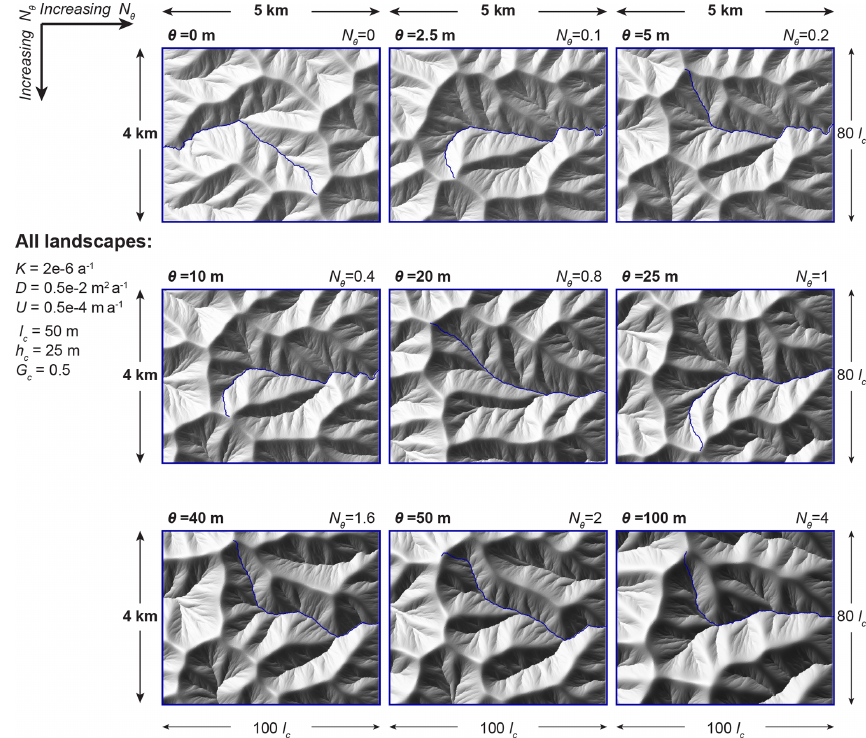
Figure 5. Influence of incision-threshold number N θ on morphology of ridges, hillslopes, and valleys. Shaded relief plots corresponding to the blue rectangular regions in Fig. 4 are arranged such that N θ increases from left to right and from top to bottom (identical to Fig. 4; see parameter values in Table 4). The illumination angle is consistent among all panels; thus greater contrasts in grayscale correspond to steeper slopes. Maps with higher N θ have steeper slopes, as indicated by the greater contrast. Maps with higher N θ also exhibit wider ridges and interfluves (note the distance between tips of valley networks and basin or subbasin divides), with the result that ridges and hillslopes appear smoother in plan